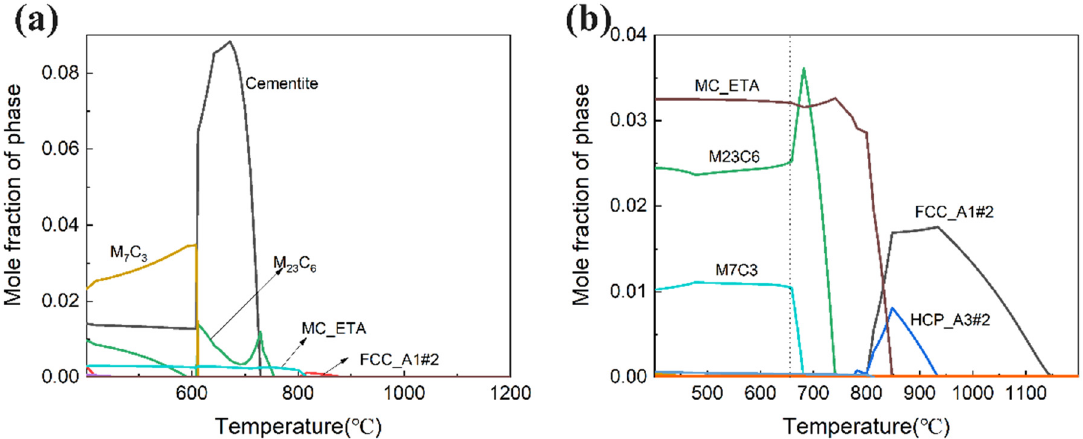
Figure 1: The balanced precipitates of the two steels: ( a ) 5CrNiMoV and ( b )